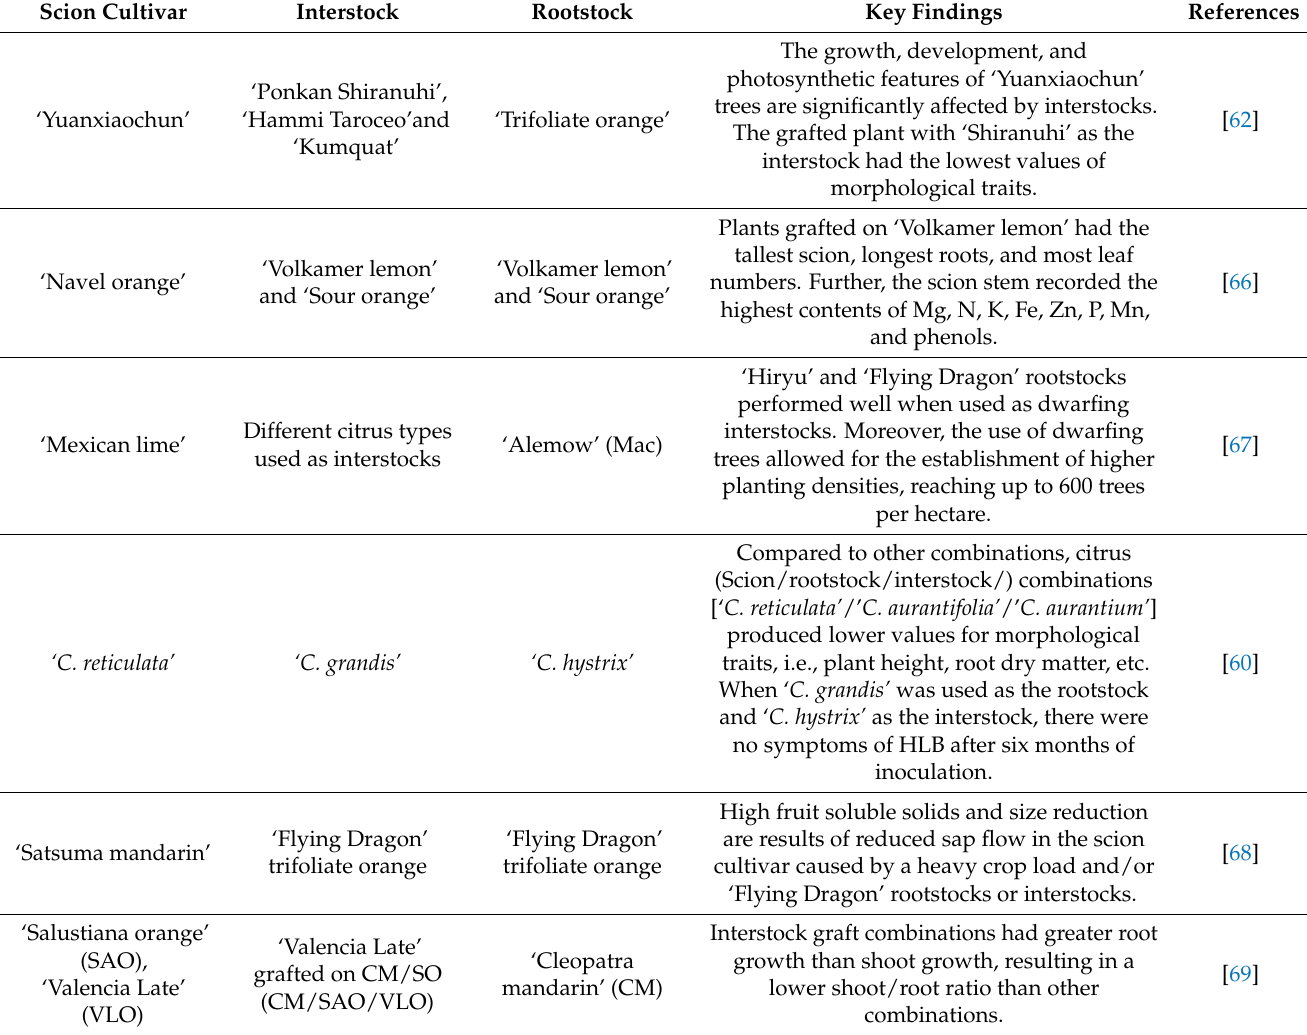
Table 3. Reduction of scion growth due to the